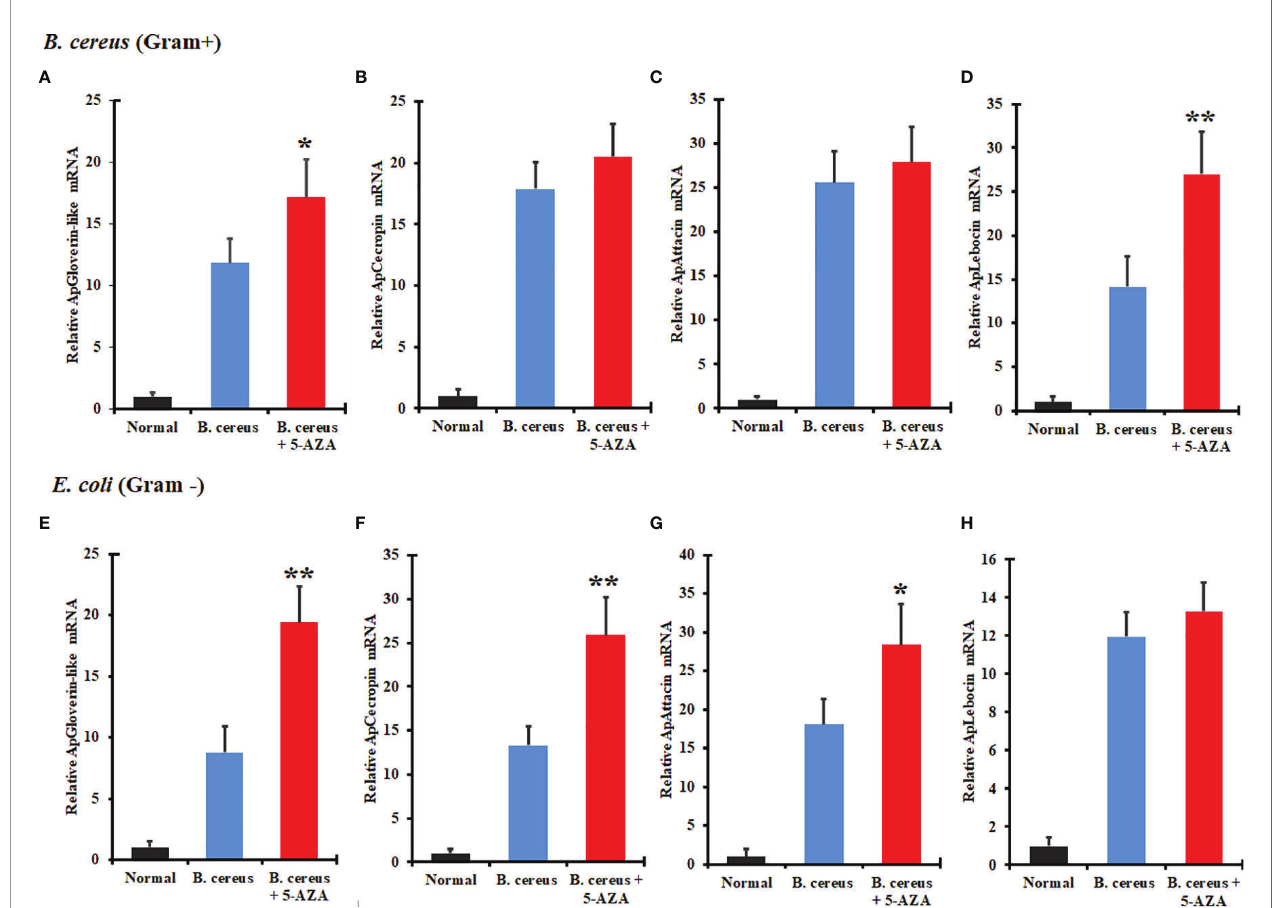
FIGURE 10 | Treatment with 5-AZA modulated the expression of antimicrobial peptides (AMPs) in A. pernyi following bacterial infections. RT-qPCR analysis of gloverin-like (A, E) , cecropin (B, F) , attacin (C, G) , and lebocin (D, H) con fi rmed that 5-AZA administration altered the expression levels of AMPs in response to B cereus (A – D) and E. coli (E – H) . 18S was used as the reference gene in RT-qPCR. Reactions from three biological replicates were repeated three times. Bars show mean ± S.E. (n = 3), and asterisks indicate signi fi cant differences (* p < 0.05, ** p <